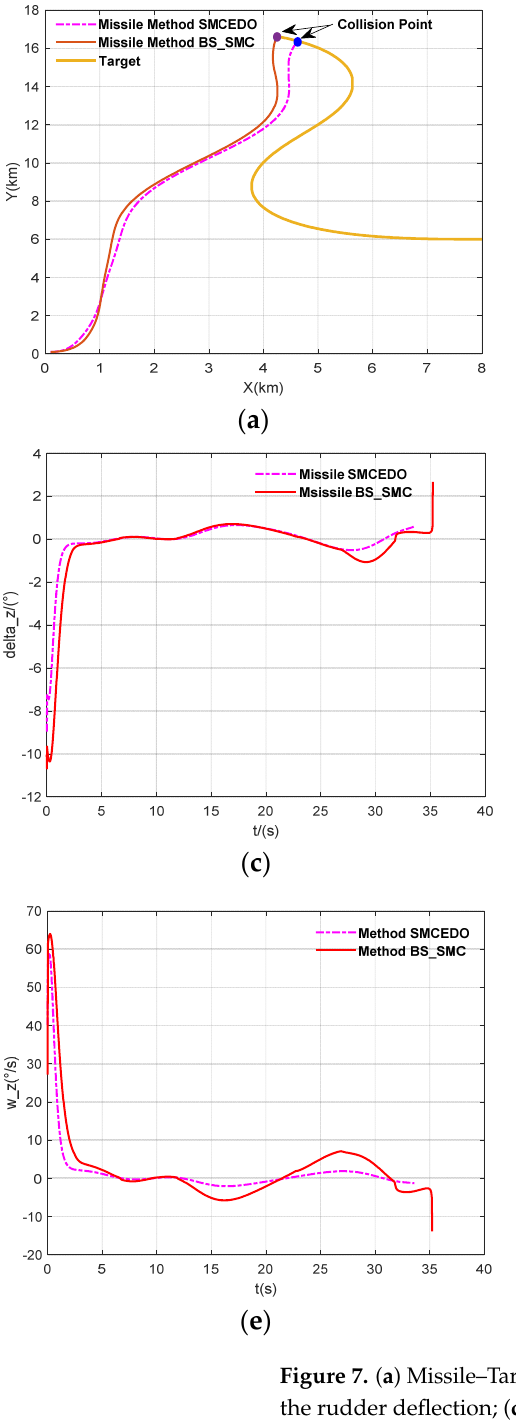
Figure 6. T he maneuver characteristics of the target.